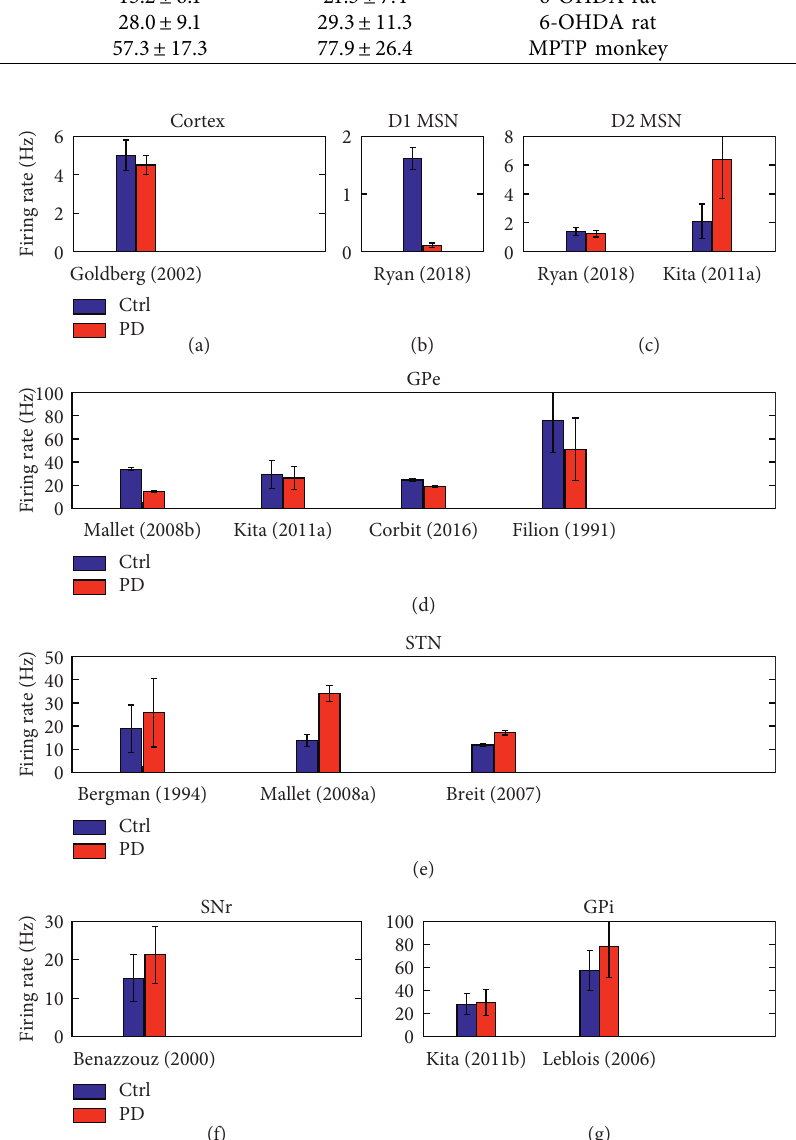
Figure 2: Changes in the neuronal firing rates in corticobasal ganglia circuits (denoted above each panel), which are listed in Table 1, are visualized for a better comparison between their behavior in control (blue) and PD (red) condition.